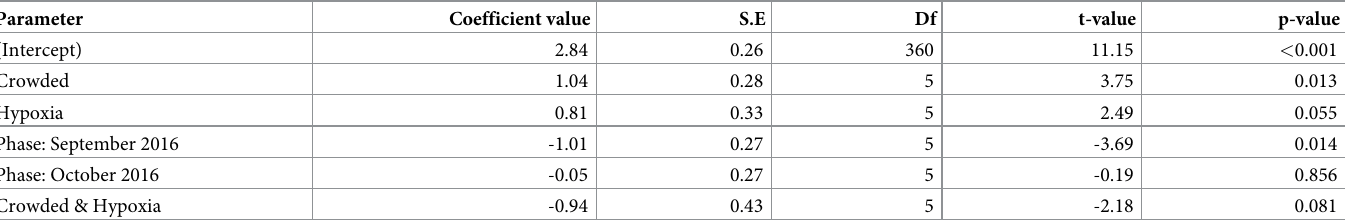
Table 3. Tail beat frequency during stressor modelling results. Linear mixed model coefficients for the relationship between stressor treatments (“Crowded”, “Hypoxia” and their interaction), experimental phase (“Phase”) and tail beat frequency during the application of the stressor.